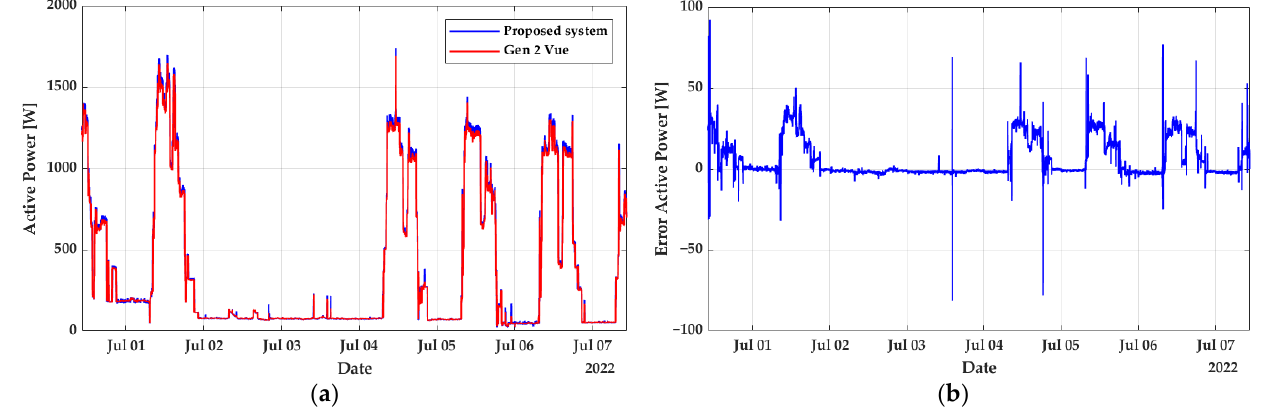
Figure 16. Active power in line 1: ( a ) comparison between the proposed system and the commercial monitor; ( b ) measurement errors of the proposed system with respect to the commercial monitor.